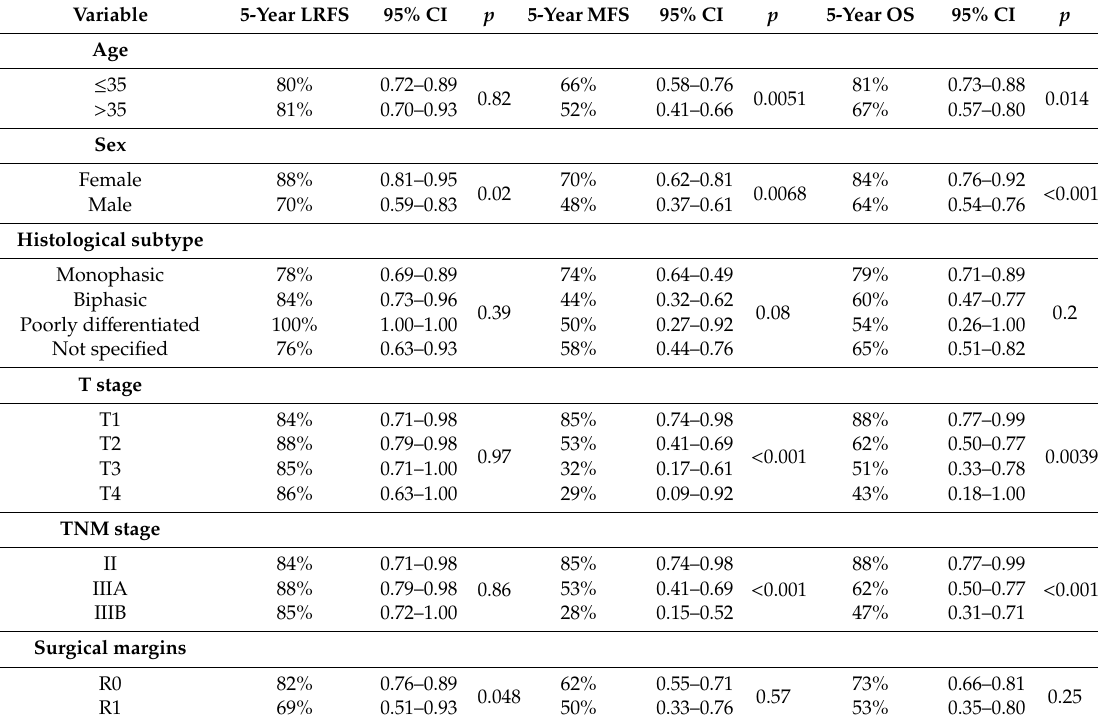
Table 2. Univariate analysis of variable factors for LRFS, MFS and OS.